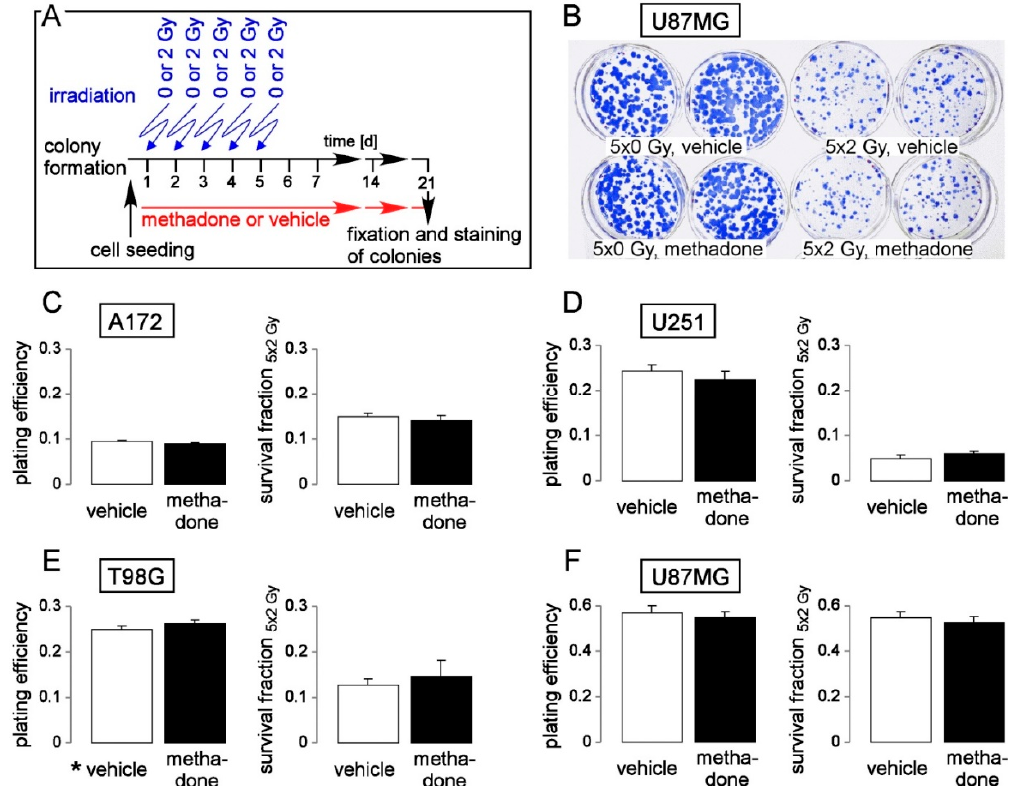
Figure 5. Methadone in a clinically relevant concentration (2 µM) does not impair clonogenic survival or radioresistance of human glioblastoma cells. ( A ) Experimental protocol of pre-plating colony formation depending on methadone concentration (0 or 2 µM) and fractionated irradiation (5 × 0 or 5 × 2 Gy). ( B ) Coomassie blue-stained colonies regrown from 5 × 0 Gy ( left )- and 5 × 2 Gy ( right ) U87MG cells co-incubated with either 0 µM (vehicle, ethanol, upper row) or 2 µM (lower row) methadone. ( C – F ). Mean (± SE, n = 6) plating efficiency ( left ) and survival fraction 5 × 2 Gy ( right ) of A172 ( C ), T98G ( D ), U251 ( E ), and U87MG ( F ) glioblastoma cells co-incubated with either 0 µM (vehicle, open bars) or 2 µM methadone (closed bars). For pre-plating colony formation, plated cells were irradiated (0 or 2 Gy on days 1, 2, 3, 4, and 5) and post-incubated in the absence (vehicle, ethanol) or presence of methadone (2 µM) until formation of colonies. Thereafter, plating efficiencies and survival fractions were calculated as described in the legend of Figure 4.